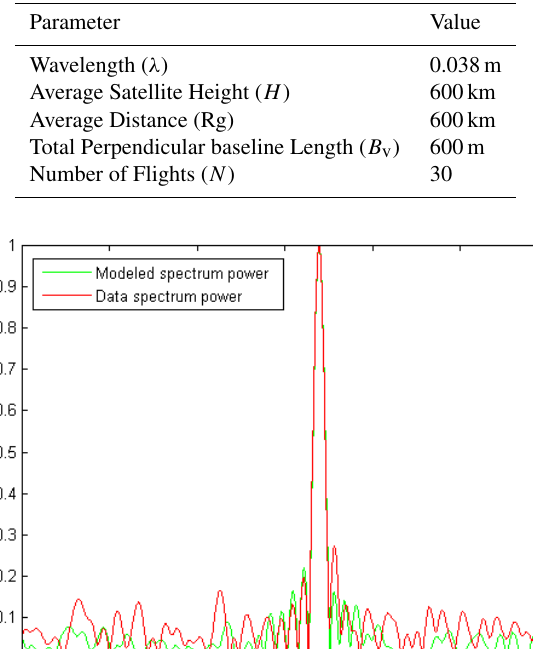
along the tomography direction s . γ ( s ) represents the scatter- ing value in the vertical oblique direction. ξ n represents